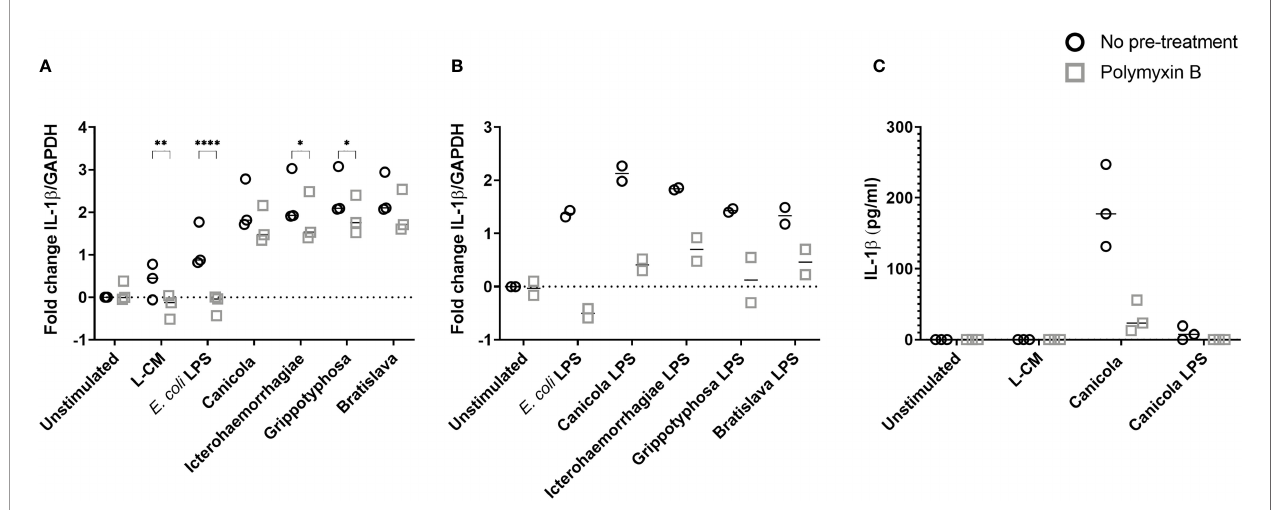
FIGURE 2 | IL-1 b production following stimulation with inactivated Leptospira is partially dependent on leptospiral LPS in canine moDC. (A, B) RT-qPCR was performed on mRNA from canine moDC stimulated for 6 (h). (A) Cells were incubated with E. coli LPS, leptospiral culture medium (L-CM) as positive and negative controls, respectively, whole-inactivated L. interrogans serogroup Canicola, Icterohaemorrhagiae or Bratislava or L. kirschneri serogroup Grippotyphosa (circle). In addition, moDC were incubated with Leptospira pre-treated with polymyxin B (square). IL-1 b gene expression was normalized to GAPDH and fold change in expression relative to the unstimulated control is shown. Data represent mean values from three independent experiments. Each experiment was performed using two replicates per condition. A mixed-effect analysis combined with S ̌ ida ́ k ’ s multiple comparisons test was used to test for statistical signi fi cance between the untreated and polymyxin B treated sample; *p < 0.05, **p < 0.01, ****p < 0.0001. (B) Cells were incubated with E. coli LPS as control or LPS isolated from four Leptospira strains shown in A (circle). In addition, moDC were stimulated with leptospiral LPS pre-treated with polymyxin B (square). IL-1 b gene expression was normalized to GAPDH and fold change in expression relative to the unstimulated control is shown. Data represent mean values from two independent experiments. Each experiment was performed using two replicates per condition. (C) IL- 1 b protein was measured in the supernatants of canine moDC incubated for 48 h with leptospiral culture medium as control, whole inactivated serogroup Canicola or its puri fi ed LPS (circle), or polymyxin B treated stimuli (square). The experiment was performed once in three technical replicates per